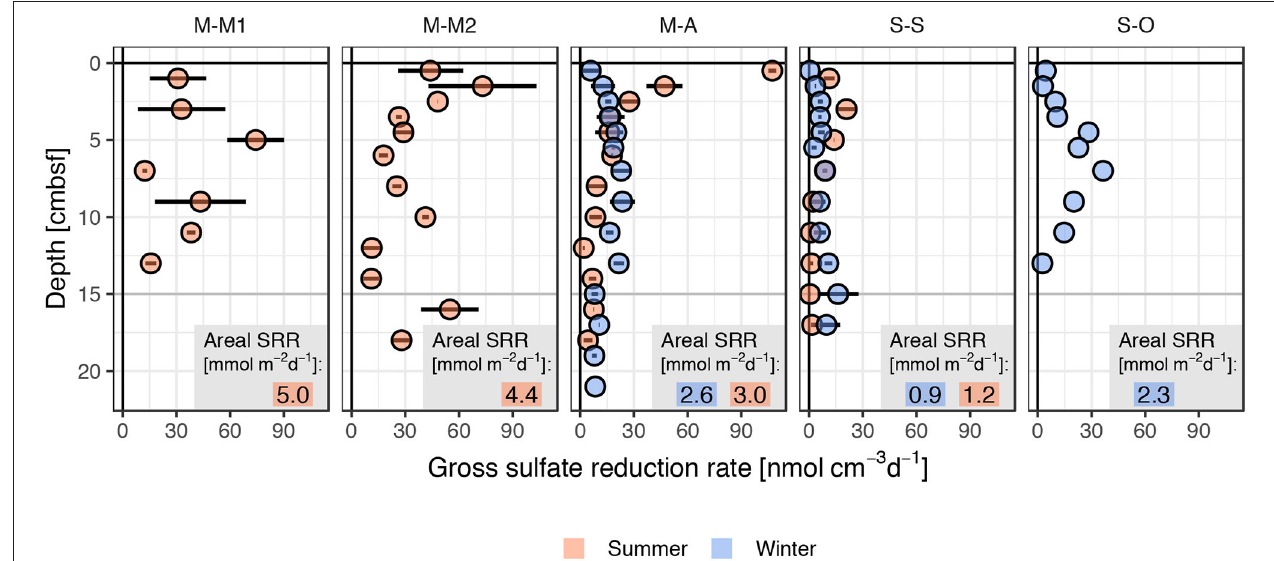
FIGURE 5 | Vertical distribution of sulfate reduction rates measured in muddy (M-A, M-M1, and M-M2) and sandy (S-S and S-O) study sites in summer and winter. Values are given as mean and range of two replicates except for S-O, where only one core was incubated. Areal SRR [ mmol m − 2 d − 1 ] are shown separately for summer and winter as depth-integrated sulfate reduction rates in the top 15 cm of the